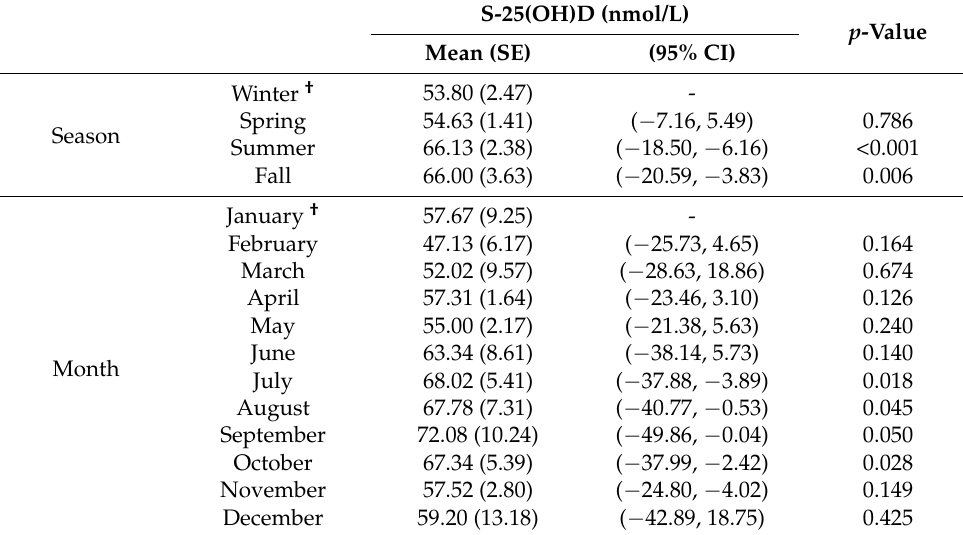
Table A5. Weighted means for S-25(OH)D (nmol/L) by season and month of blood test using Cycles 3 and 4 of Canadian Health Measures Survey data.